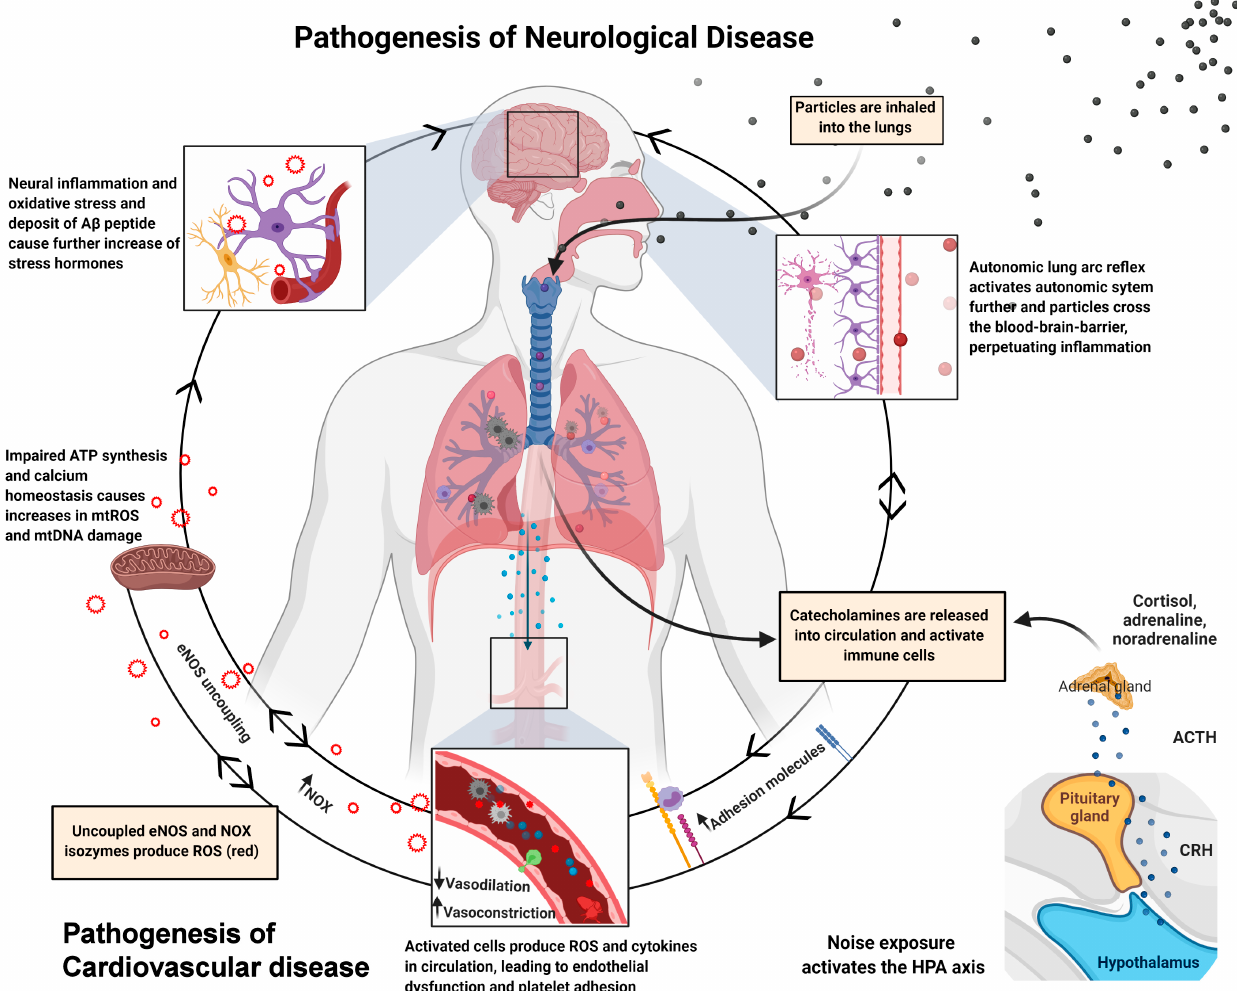
Figure 3. Pathophysiological mechanisms of neurological and cardiovascular disease induced by air pollution and noise exposure. Arrows indicate directions of pathways and pathomechanisms. Red circles indicate the release adverse signaling ROS. Summarized from Münzel et al. [142] and presented data in the present review article. Created with BioRender.com. 471